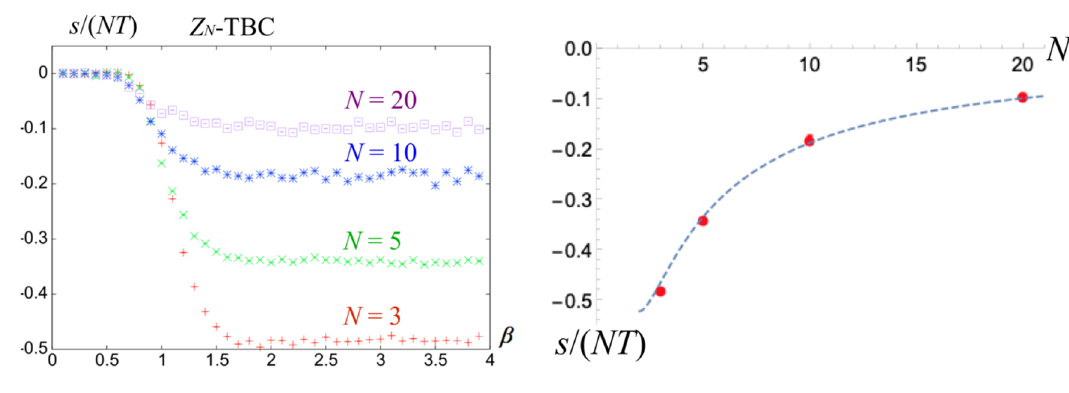
Figure 11 . (Left): pseudo-entropy density ( s= ( NT ) = N 2 (Right): the averaged values of pseudo entropy density for N = 3 ; 5 ; 10 ; 20 ( (cid:12) = 3 : 0 (cid:0) 3 : 9) after they are well saturated. The broken curve stands for the analytically speculated value (cid:0) 2 (cid:25) up to O (1 =N 2 )